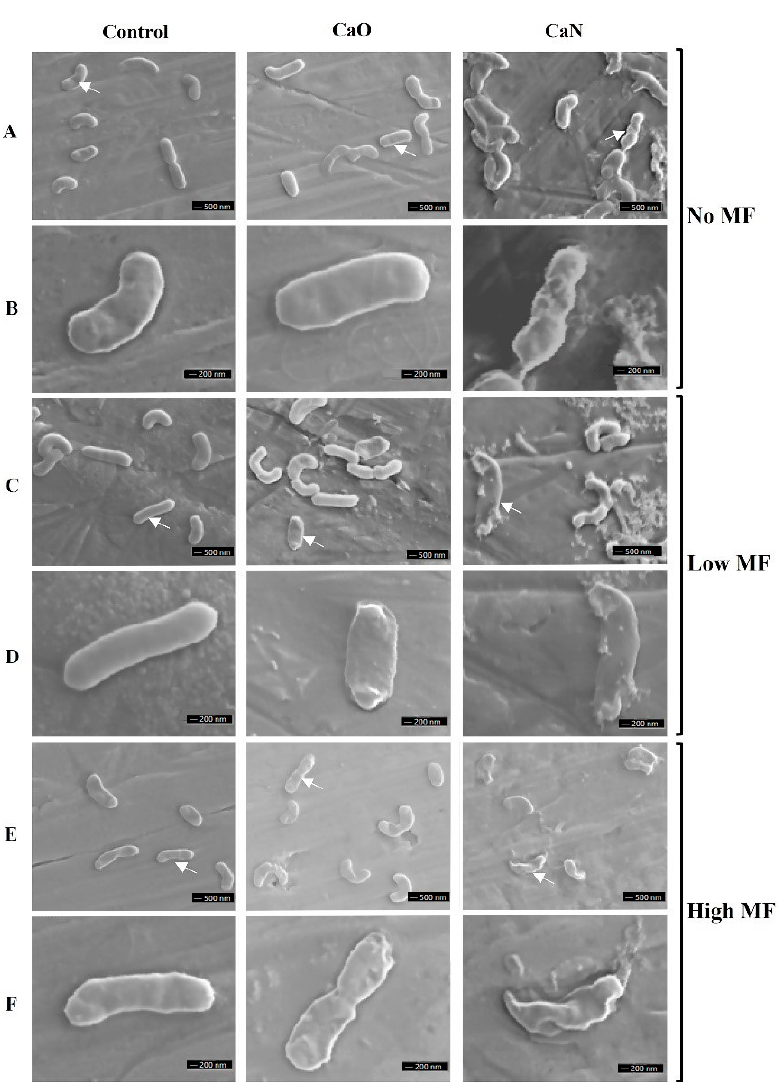
Figure 9. Representative scanning electron microscopy images of various protocols with and without nanoparticles. ( A ) Untreated and samples with CaO and CaN only; ( C ) 10 mT, 100 kHz/60 min treated and samples after CaO and CaN + 10 mT AMF procedure; ( E ) 125 mT, 200 kHz/30 min treated and samples after CaO and CaN + 125 mT AMF procedure; magnified images of bacteria highlighted with white arrows are shown in ( B , D , F